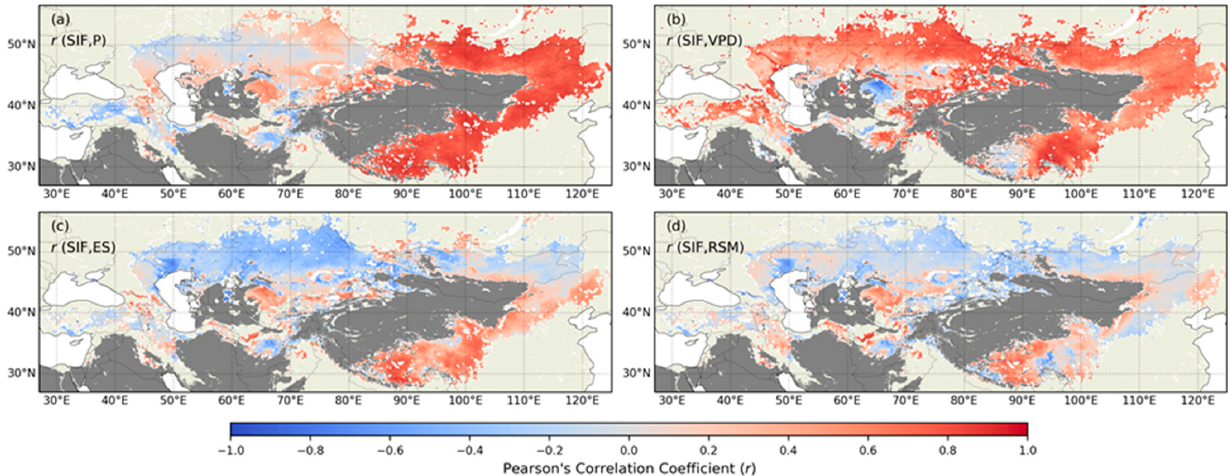
Figure 2. The spatial Pearson’s correlation coefficient ( r ) of solar-induced chlorophyll fluorescence (SIF) with precipitation (P), vapor pressure deficit (VPD), evaporative stress (ES), and root zone soil moisture (RSM). ( a – d ) respectively represented the spatial r of SIF with P ( r (SIF, P)), VPD ( r (SIF, VPD)), ES ( r (SIF, ES)), and RSM ( r (SIF, RSM)).